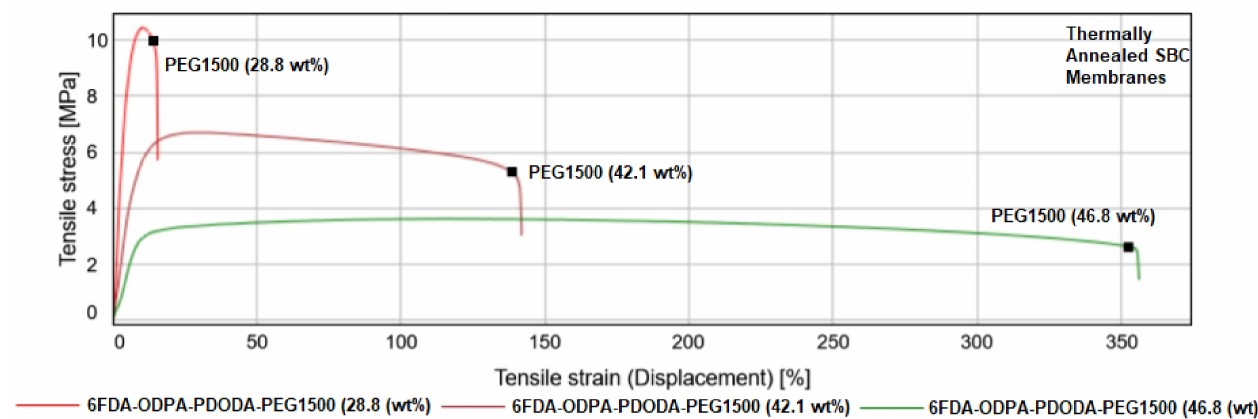
Figure 4. Stress–strain curves obtained from the tensile test for not thermally treated SBC membranes with changing PEG1500 content.